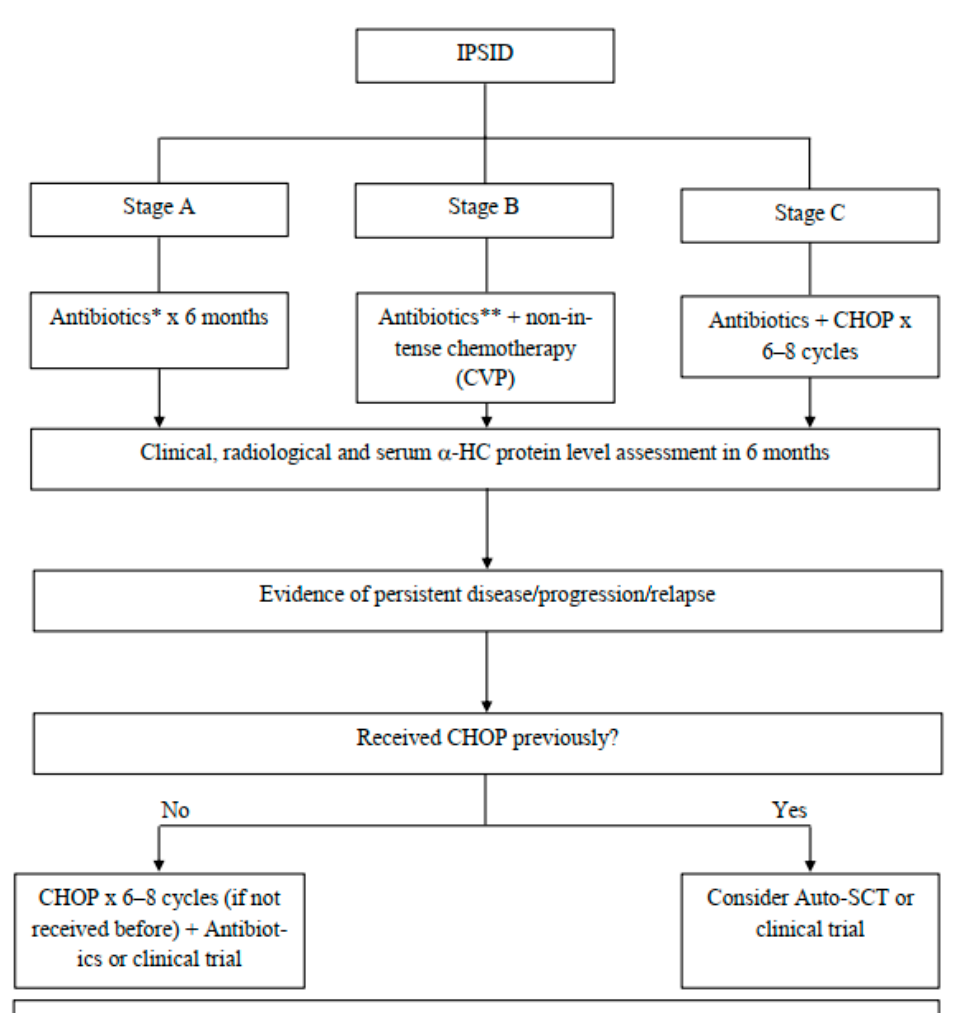
Figure 3. Suggested approach for management of IPSID stages and